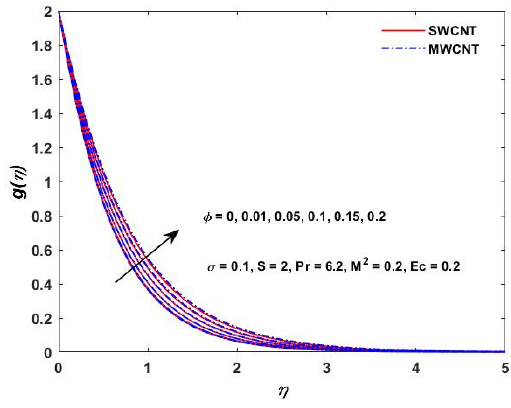
Figure 5. Volume fraction verses velocity 𝑔(𝜂).